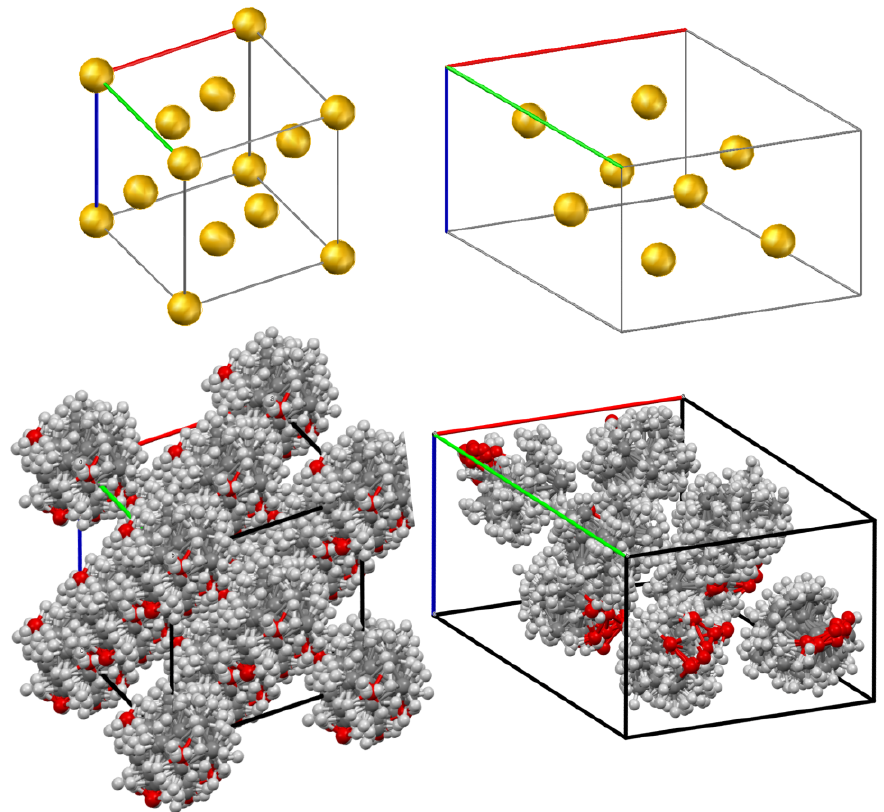
Figure 7. Crystalline structures of the ( a ) high-temperature fcc phase and ( b ) room-temperature hex orientationally disordered phases of camphor. Yellow spheres in the upper figures mark the center-of-mass positions of camphor molecules in the crystalline cells of the fcc and hex phases.